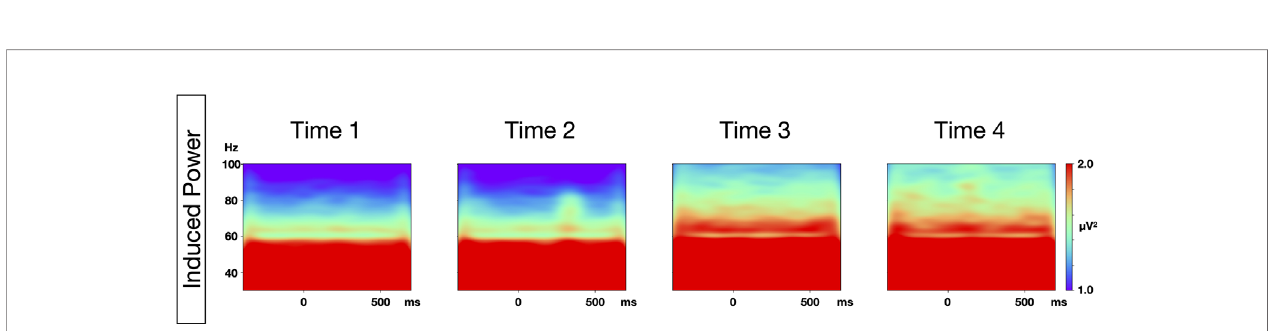
FIGURE 2 | Time-frequency maps of induced power at each time point. Grand average time-frequency maps at the Cz electrode at each of the four time